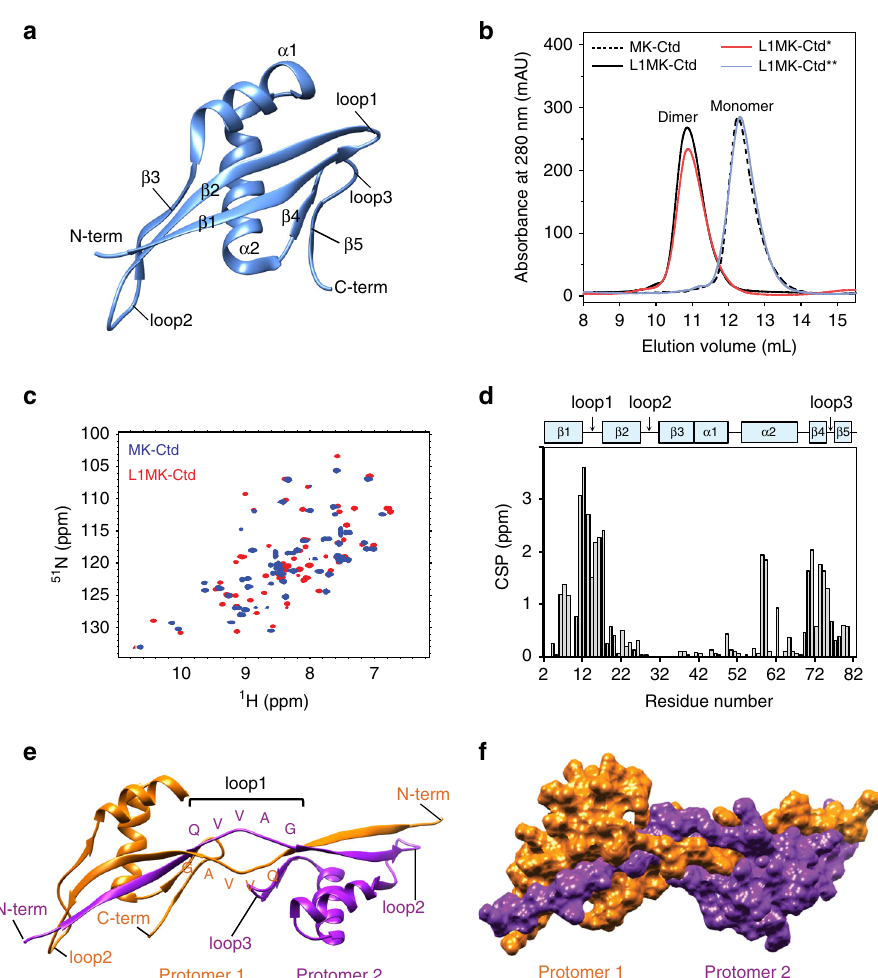
Fig. 5 Domain swapping in MK-Ctd. a Structure of the C-terminal domain of the hyperthermophilic protein MK0293 (MK-Ctd) (PDB ID: 3C19) is shown. Different secondary structural elements, the N-termini and C-termini, and loop1, loop2, and loop3 of MK-Ctd are indicated. b Size exclusion pro fi les of MK- Ctd, L1MK-Ctd, L1MK-Ctd*, and L1MK-Ctd**, at pH 8, are shown. L1MK-Ctd* and L1MK-Ctd** are variants of L1MK-Ctd, in which the QVVAG sequence was mutated to QVNAG and QNNAG, respectively. Elution volumes corresponding to the monomeric and dimeric species are indicated. c An overlay of the 15 N-HSQC spectra of the monomeric wt MK-Ctd (blue) and the dimeric L1MK-Ctd (red) is shown. d CSP between MK-Ctd and L1MK-Ctd is shown for each residue. A weighted chemical shift difference ( 1 H and 15 N) is plotted. For reference, the secondary structural arrangement of MK-Ctd is indicated on the top. e Ribbon representation of the solution dimer of L1MK-Ctd is shown. The two polypeptide chains contributing to the swapped dimer are colored in orange and purple. f A space- fi lling model of the L1MK-Ctd domain-swapped dimer is shown to highlight the quaternary arrangement of the protomers. Source data are provided as a Source Data fi β -turn (3 residues long) connecting two moderately extended β -strands, β 1 and β 2 (Fig. 5a). This mutant variant (L1MK-Ctd)